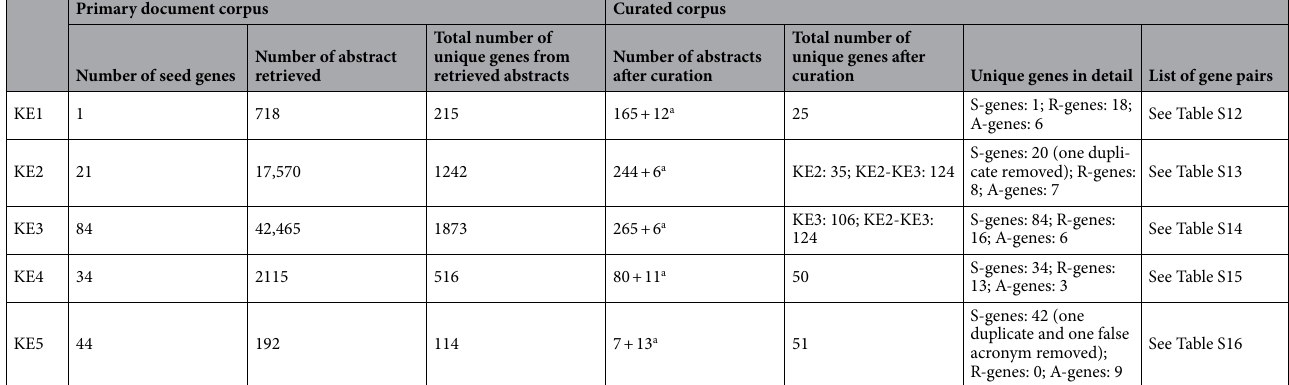
Table 1. Summary of literature reference, gene pairs pre- (Stage 1) and post- (Stage 2) curation used for building the key event (KE) networks. a Indicates number of genes that were added after a further manual inspection of key